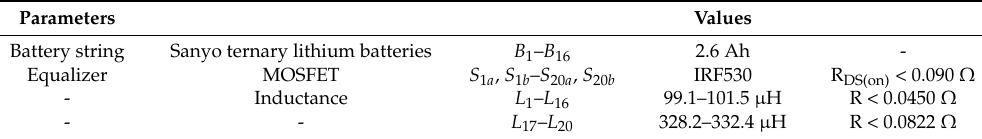
Table 5. Component values used for the equalizer.